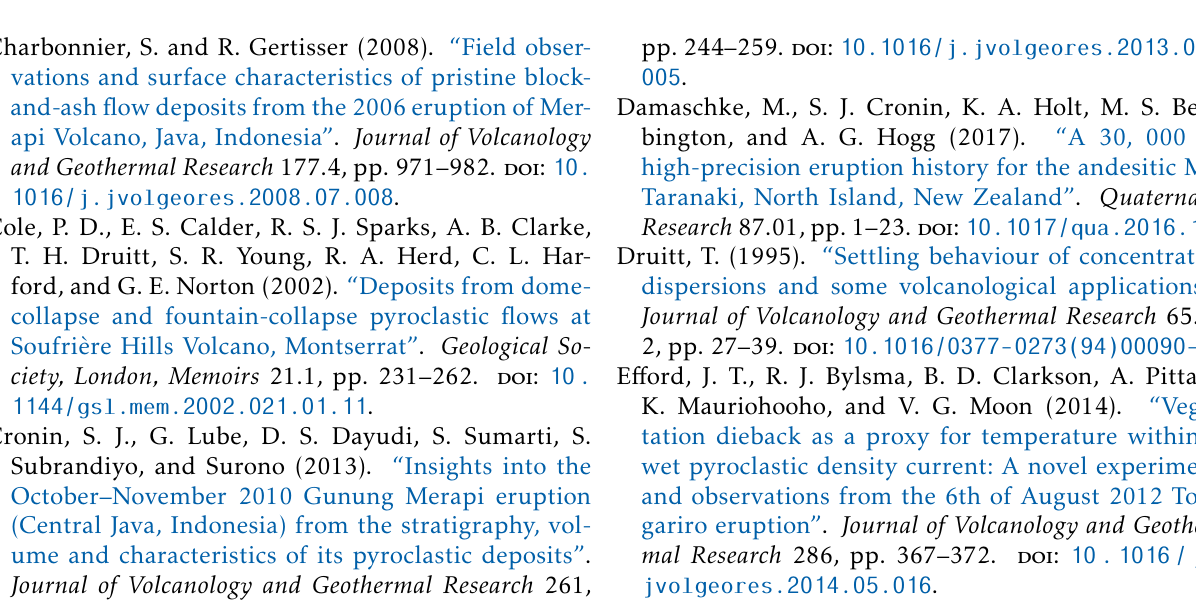
Figure 7: Comparison of sites M1 [A] and M2 [B] from the Waiweranui/Turehu unit deposited at temperatures above 480 ◦ C with site M3 [C] from the Puniho unit deposited at near ambient temperature. Similar characteris- tics are seen among all units, including matrix-support and color of matrix, and clast size, sorting, rounding, and color. The M3 deposit picture shows stronger horizontal fabric and clast trains than the other sites pictured, but these features are common in the hot-emplaced units